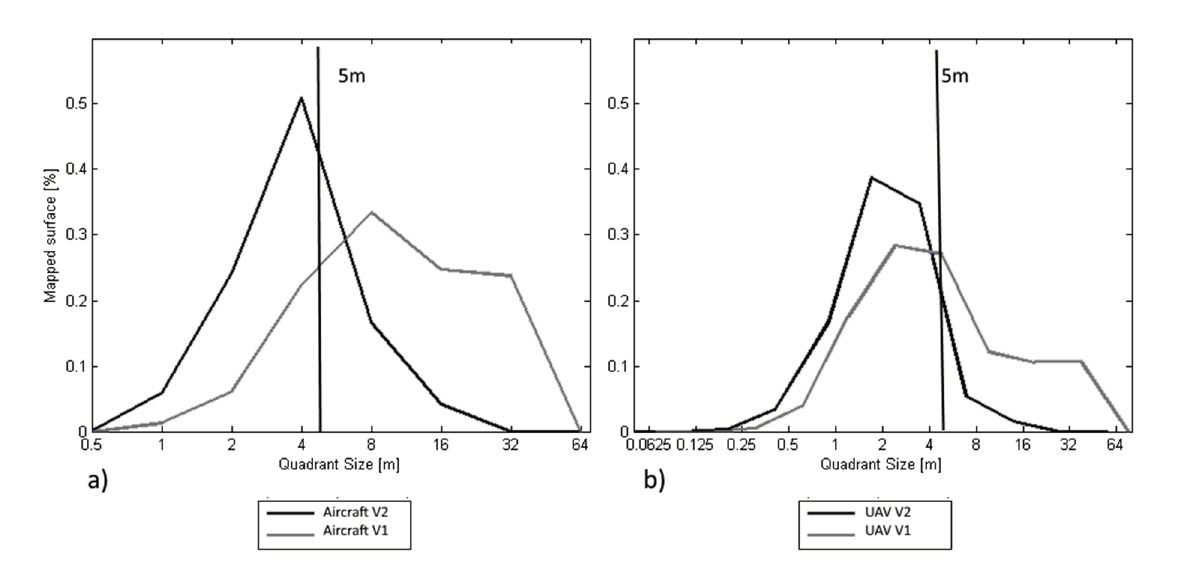
Figure 4. ( a ) Distribution of dimensional classes for Aircraft resolution and ( b ) distribution of dimensional classes for UAV